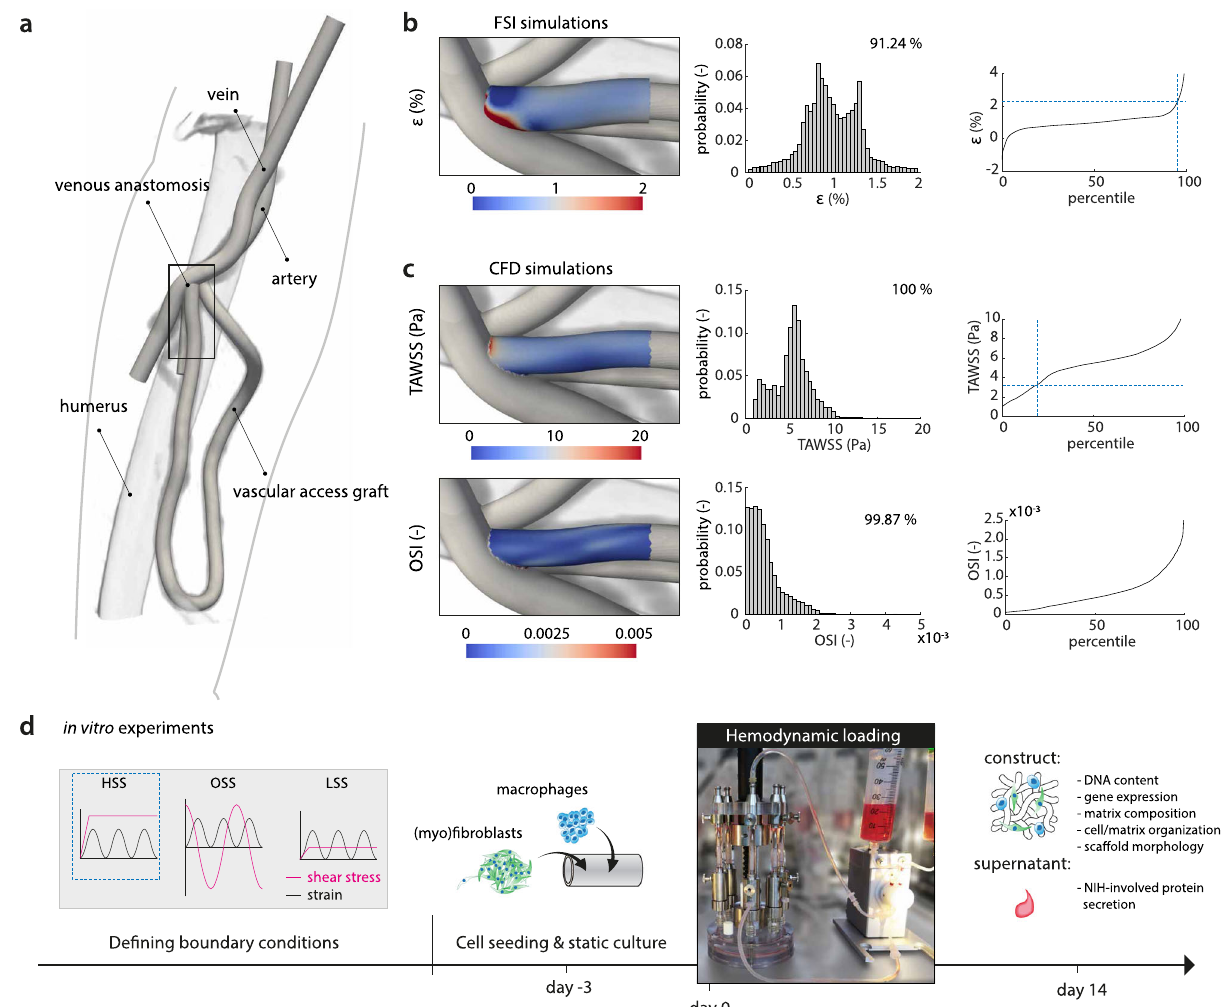
Fig. 2 Computational characterization of the biomechanical environment in an AVG as input for scaffold-driven neotissue formation in vitro. a Geometry of the arteriovenous graft (AVG), looped between the axillary artery and axillary vein, that was used for the computational model (humerus inserted as a reference, venous anastomotic region indicated by rectangle). b Fluid – structure interaction (FSI) simulations and c computational fl uid dynamics (CFD) simulations to compute the local strains and shear stresses in the AVG, respectively (histograms and associated percentile plots showing the distribution of the quanti fi ed read-out parameters ( ε strain, TAWSS time-averaged wall shear stress, OSI oscillatory shear index). The dashed lines in the percentile plots correspond to the boundary conditions of the high shear stress (HSS) group in the in vitro experiments). d The computational results guide the in vitro experiments by de fi ning the relevant boundary conditions (HSS high shear stress, OSS oscillating shear stress, LSS low shear stress). (Myo) fi broblasts and PMA-stimulated THP-1 cells (macrophages) are co-seeded in the scaffolds using fi brin. After 3 days of static culture, the constructs are exposed to HSS, OSS, or LSS during 14 days, all in the presence of strain. After the dynamic culture, constructs and supernatants are collected and processed for further analysis. a is derived from Quicken et al. 19 with